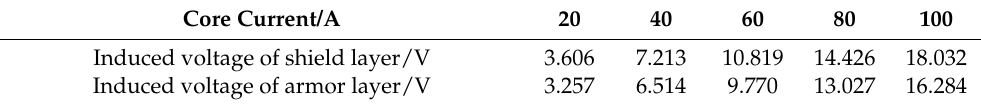
Table 1. Induced voltage of shield layer and armor layer under different core currents.